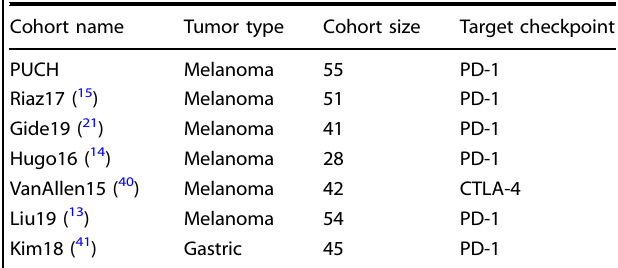
Table 2. Cohorts used in this